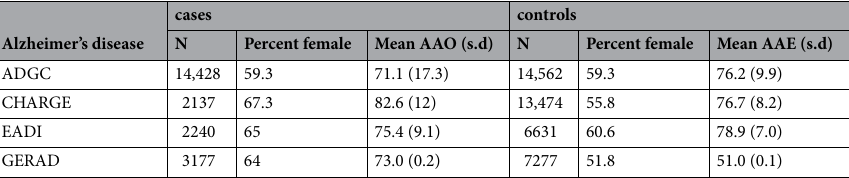
Table 1. Description of datasets in genome-wide association studies. AAO, age at onset; AAE, age at examination; AGDC, the Alzheimer Disease Genetics Consortium; CHARGE, the Cohorts for Heart and Aging Research in Genomic Epidemiology Consortium; EADI, the European Alzheimer’s disease Initiative; GERAD, the Cohorts for Heart and Aging Research in Genomic Epidemiology